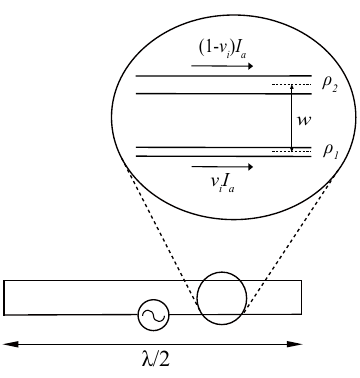
Figure 1. Folded-dipole structure.